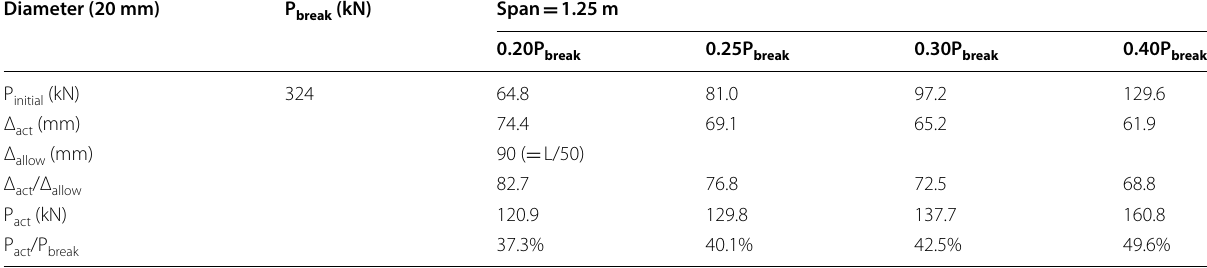
1.25 m test result. =